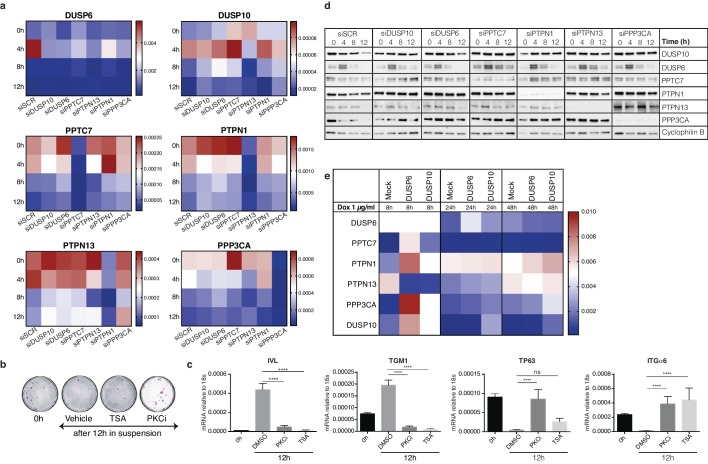
Effects on phosphatase expression of knockdowns and treatment with TSA or PKCi.(a) Heatmaps showing the effect of knocking down individual phosphatases on mRNA levels of other phosphatases with time in suspension (0, 4, 8, 12 hr). RT-qPCR is relative to 18 s mRNA (n = 3 independent transfections; see Supplementary file 9 for p-values generated by two-way ANOVA with Dunnett's multiple comparisons test). (b) Effects of TSA and PKCi on clonogenicity of keratinocytes recovered following suspension in methylcellulose for 12 hr. Representative dishes of n = 3. (c) mRNA levels of IVL, TGM, ITGα6, and TP63 in cells held in suspension for 12 hr. Cells were treated with TSA, PKCi or DMSO (vehicle control) (n = 3 independent treated cultures with two technical replicates each). p-values for the comparisons were generated by one-way ANOVA. (d) Western blots showing phosphatase levels in primary keratinocytes upon knockdown of scrambled control (siSCR), DUSP6, PPTC7, PTPN1, PTPN13 or PPP3CA and suspension for 0, 4, 8 or 12 hr. Cyclophilin B: loading control. (e) RT qPCR quantification of phosphatase mRNA levels (relative to 18 s mRNA) following doxycycline-induced over-expression of DUSP6, mutant DUSP6C293S and DUSP10. Cells were treated with 1 µg/ml doxycycline for 8, 24 or 48 hr (n = 3 independent cultures; see Supplementary file 10 for p-values generated by two-way ANOVA with Dunnett's multiple comparisons test).